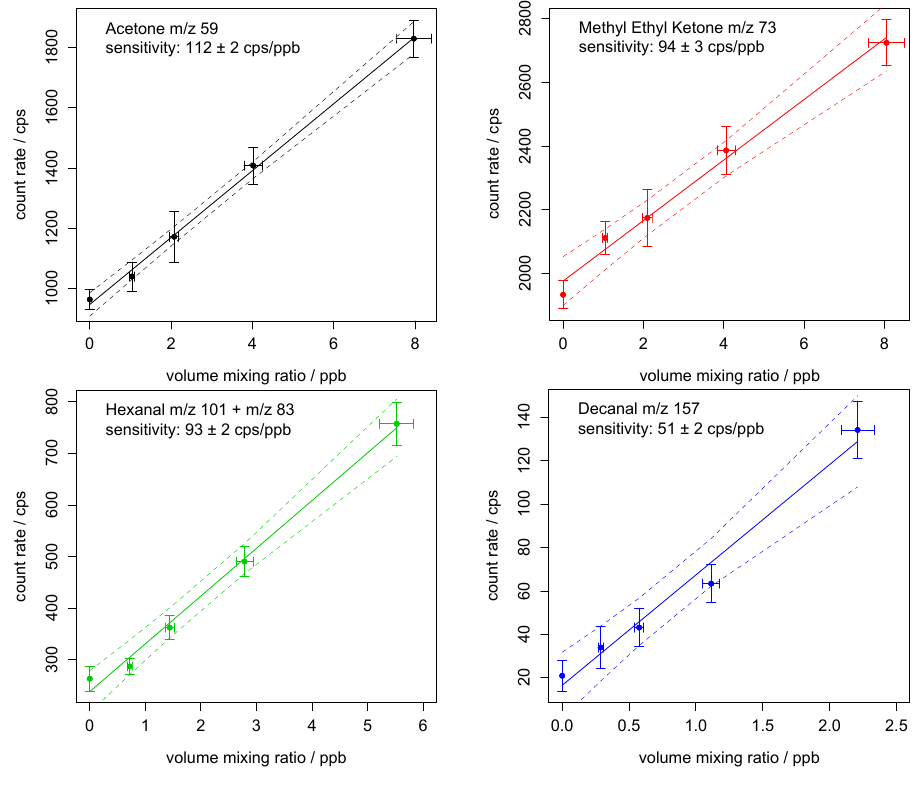
Fig. 2. Calibration curves for acetone, methyl ethyl ketone, hexanal and decanal measured at 87Td and 200 ◦ C drift tube temperature. The error bars on the x-axis represent the combined uncertainty from the accuracy of the gas standard and the error associated with the dilution of the standard. The error bars on the y-axis represent the standard deviation of the observed count rates. The dashed lines indicate the 95% confidence interval of the fitted